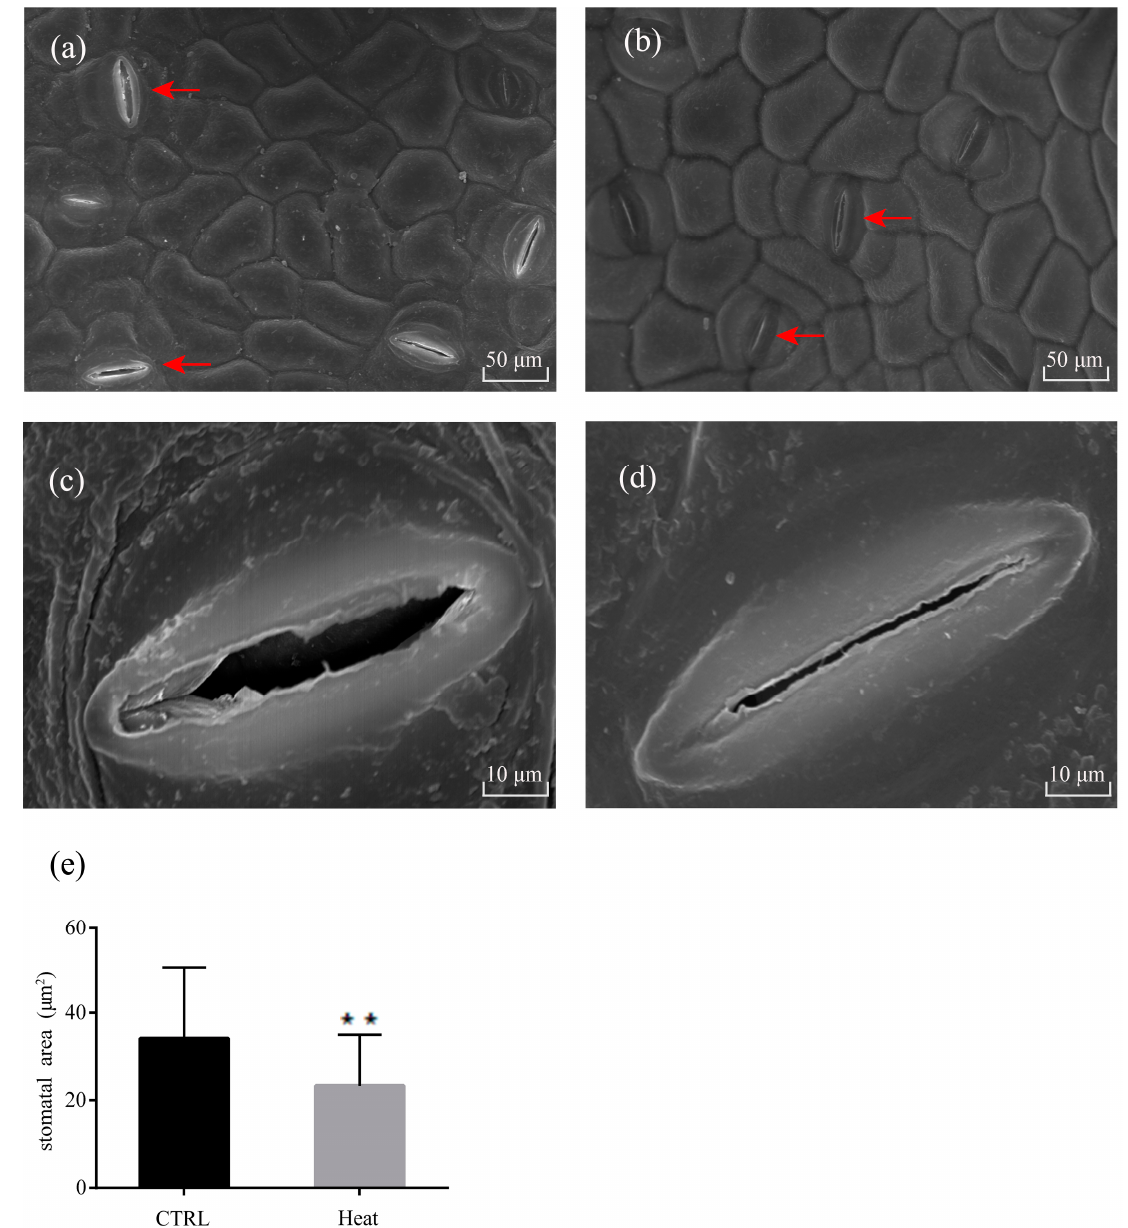
Figure 2. Changes in stomata characteristics at high temperatures. Scanning electron microscope (SEM) images of stomata and guard cells. ( a ) and ( c ), control; ( b ) and ( d ), heat treatment, 45 °C for 5 h. (e) Areas were calculated using ImageJ software ( n = 40). Bars indicate means ± SE ( n = 3). ** p < 0.01 .